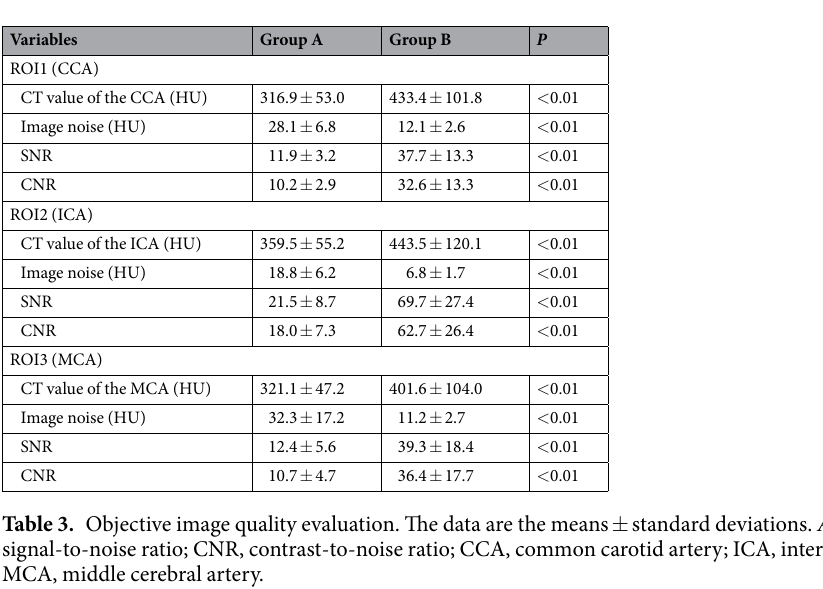
Variables Group A Group B